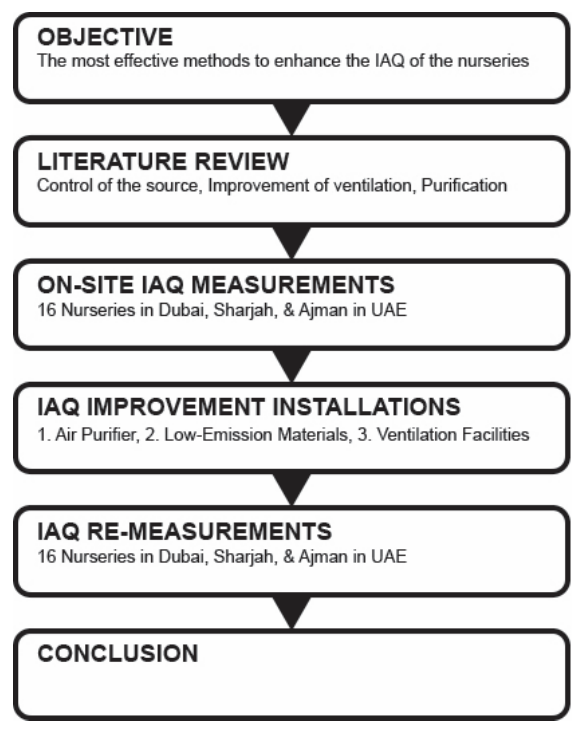
Figure 1. Research Process.